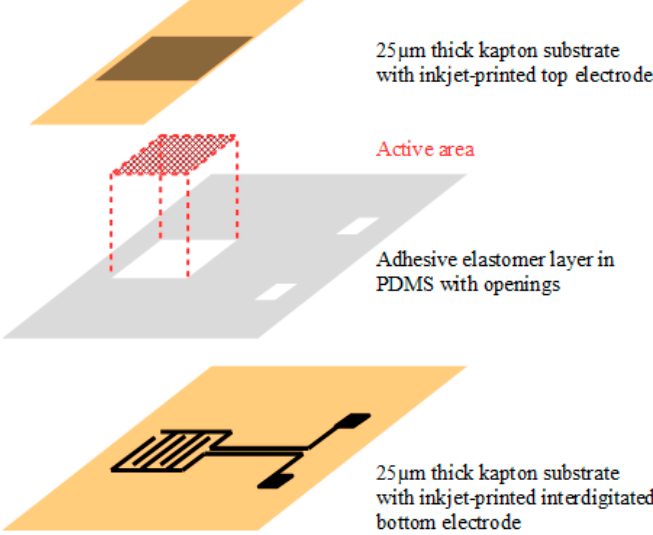
Figure 1. Structure and exploded view of the force sensor printed on flexible